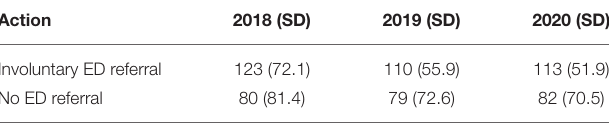
TABLE 2 | Involuntary ED referrals compared to Voluntary referrals by year. TABLE 3 | Average call times (minutes): Involuntary referrals vs. No referral.